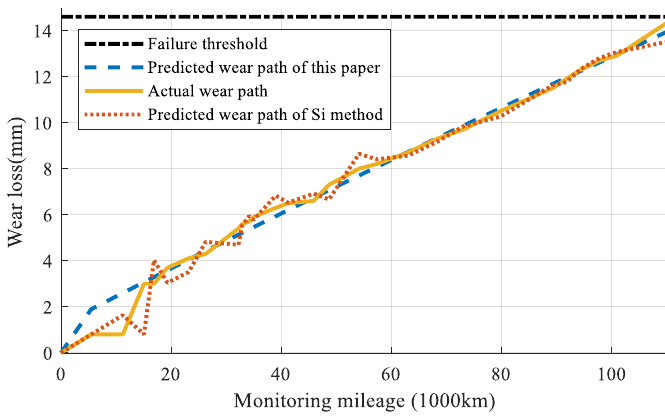
Figure 18. The actual wear path and predicted wear paths of two methods.